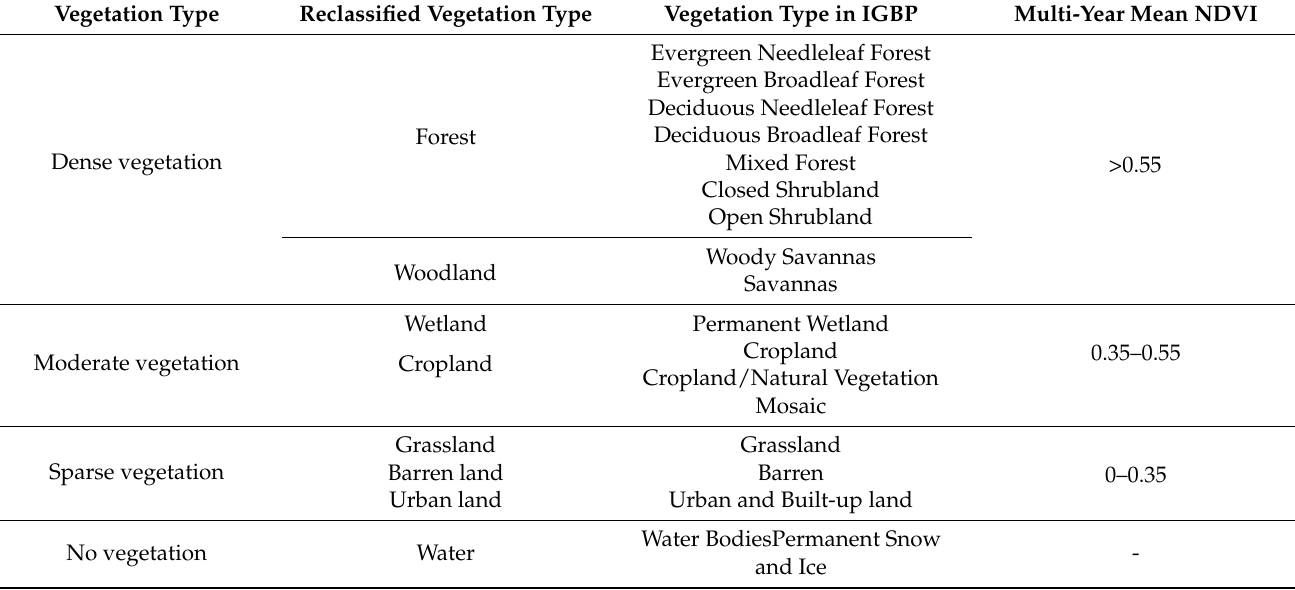
Table 1. Reclassification of 17 classes of vegetation from IGBP and classification criteria of dense vegetation, moderate vegetation and sparse